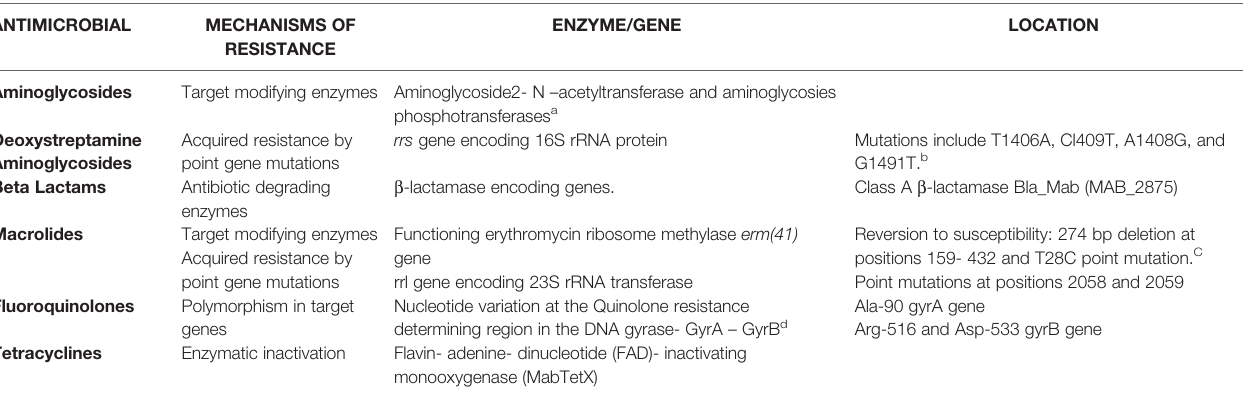
TABLE 2 | Mechanism responsible for MABC antimicrobial resistance.